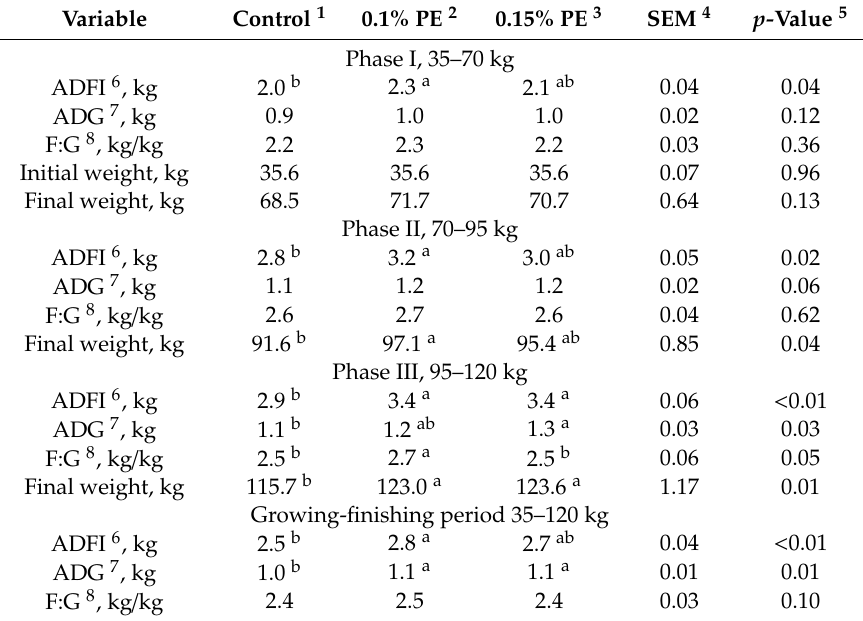
Table 2. Growth performance according to phase.